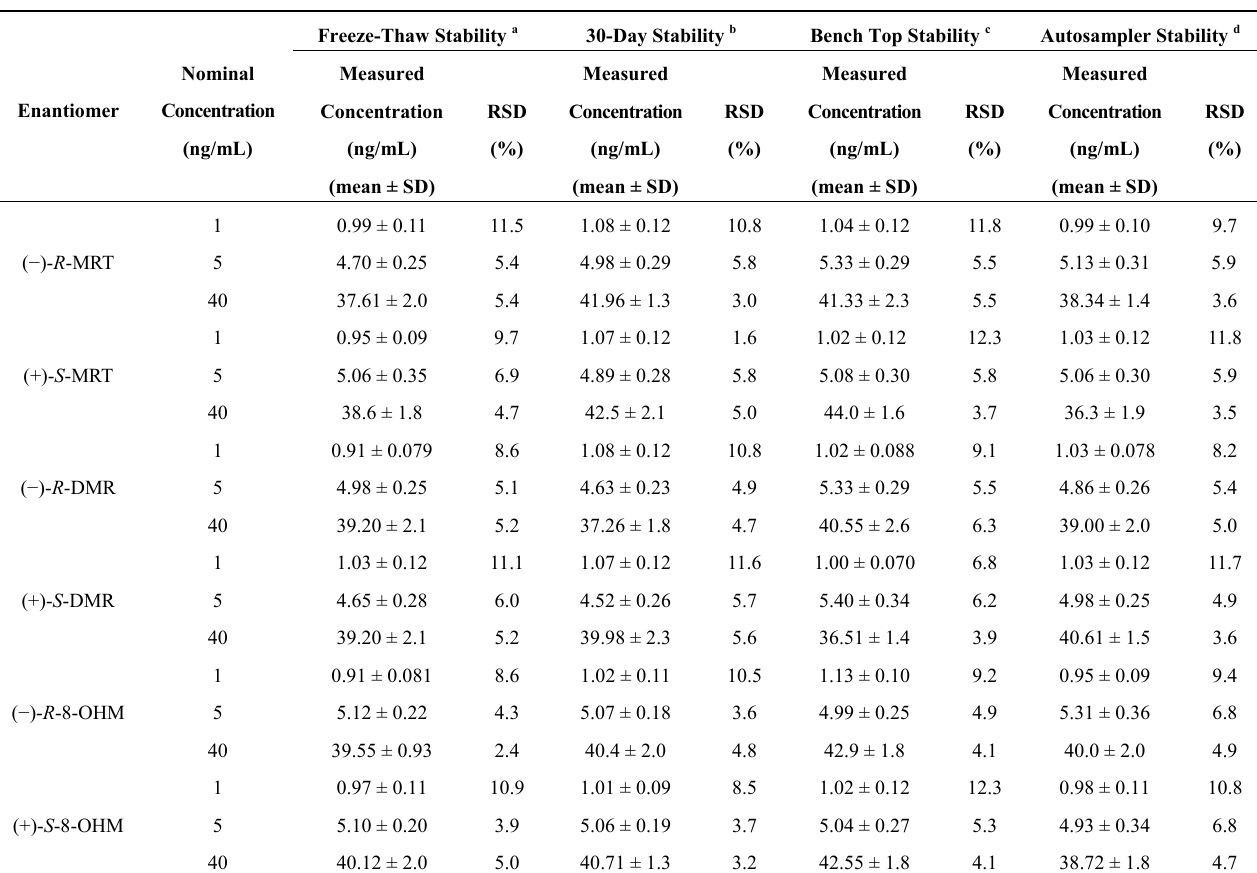
Table 5. Stability results of MRT, DMR and 8-OHM enantiomers in spiked plasma samples (n =